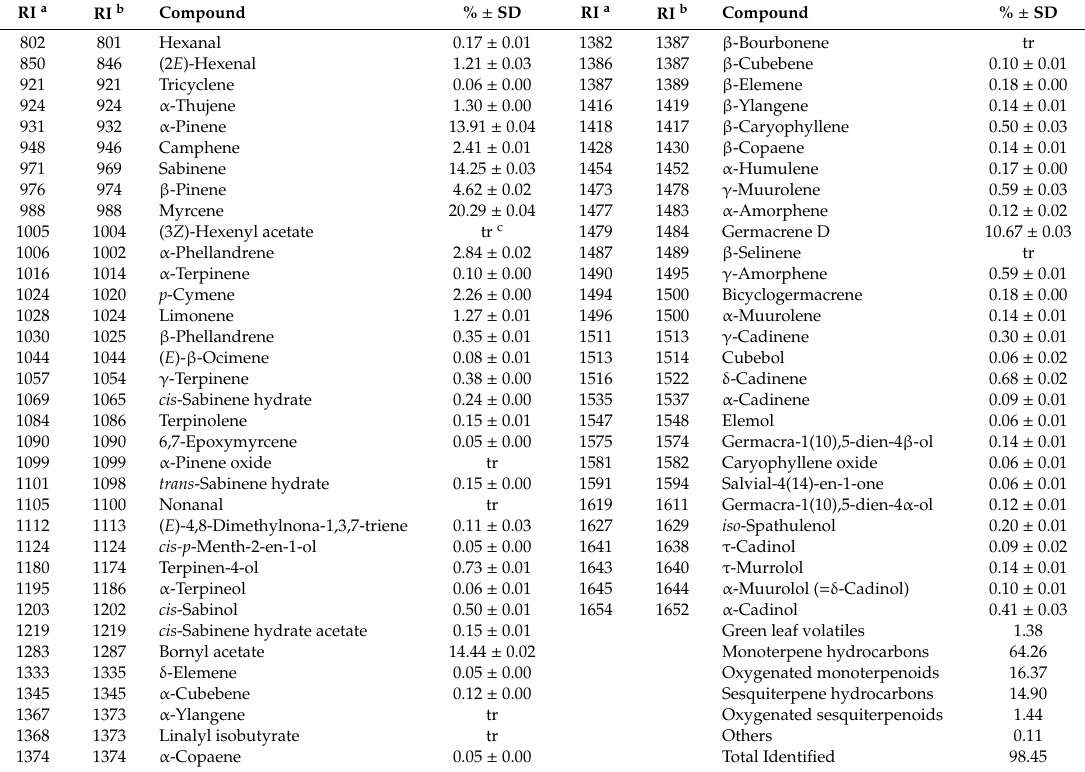
Table 9. Chemical composition of the essential oil of Solidago altissima L.